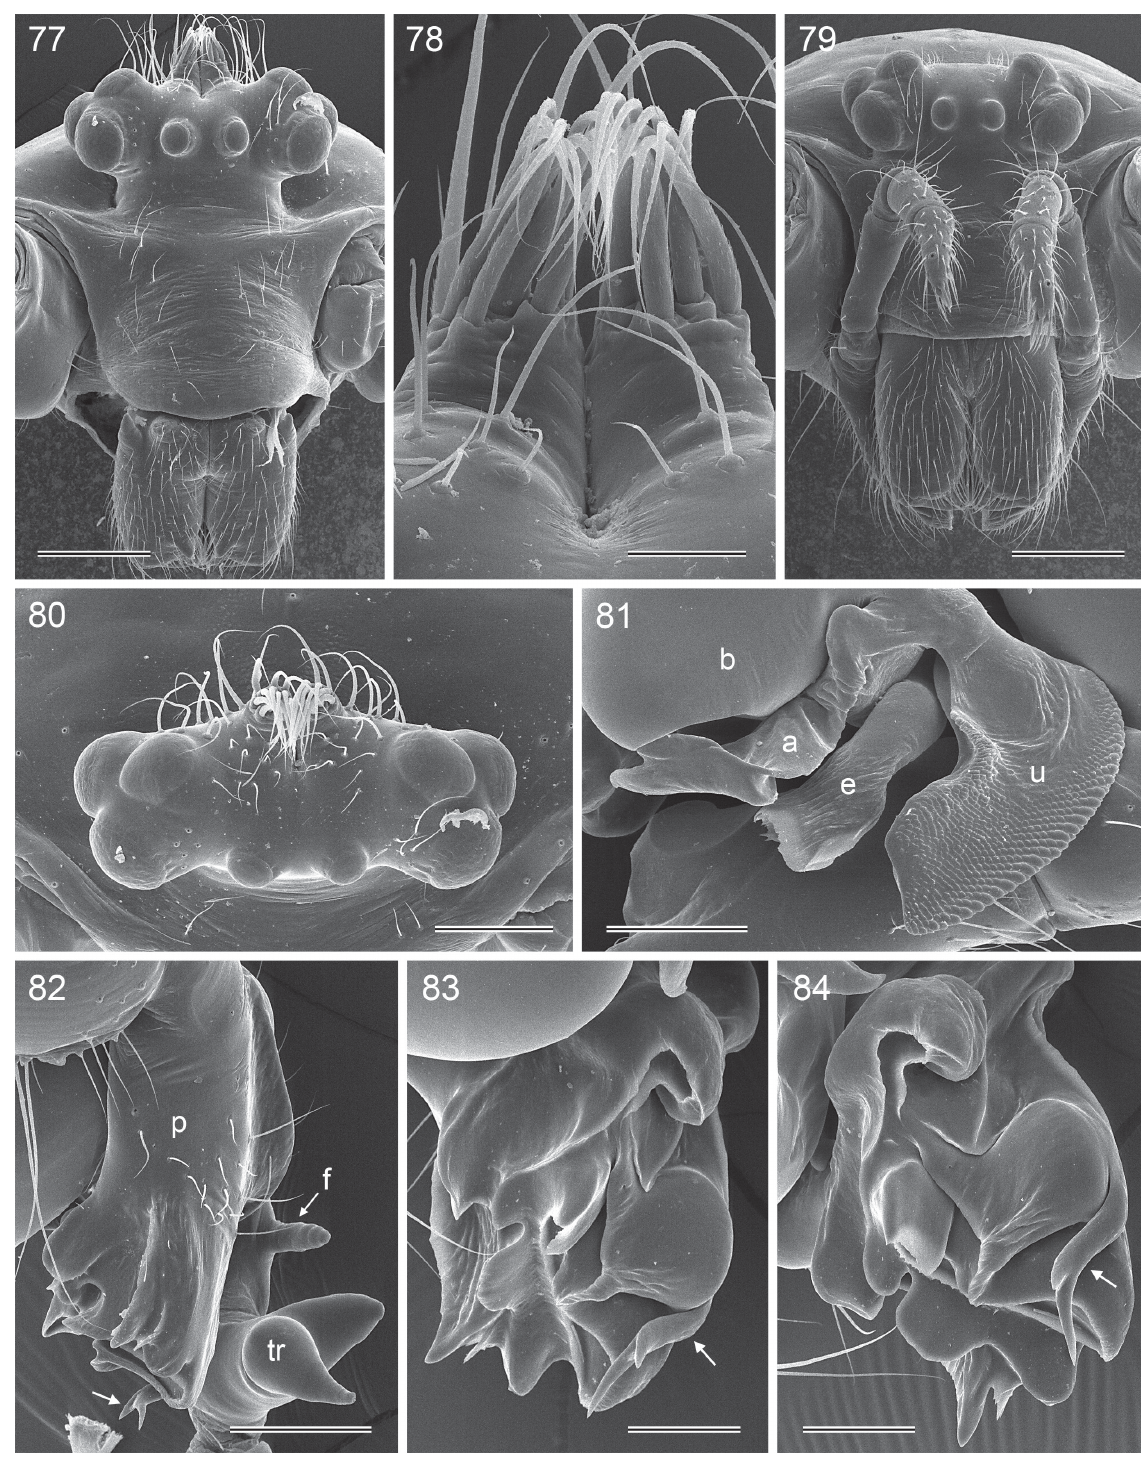
Figs 77–84. Pholcus arayat Huber, 2011, ZFMK Ar 15509. 77 . Male prosoma, frontal view. 78 . Male ocular horns and modified hairs. 79 . Female prosoma, frontal view. 80 . Male ocular area, dorsal view. 81 . right genital bulb, prolateral view. 82 . Left male palpal trochanter and procursus, dorsal view (arrow points at bifid process). 83–84 . Tip of right procursus, prolateral and prolatero-distal views (arrows point at bifid process). Scale lines: 77, 79 = 300 µm; 78 = 50 µm; 80–82 = 200 µm; 83–84 = 100